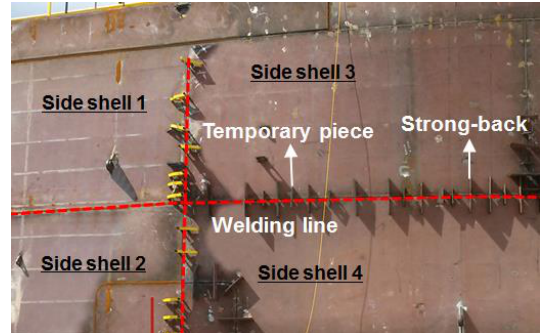
Figure 2. Temporary pieces set up for welding at block erection stage.